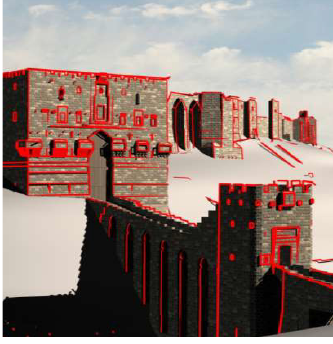
Figure 14. Plotting the architectural entrance to the Aleppo citadel. Courtesy: W. Wasbeh and G. Fangi